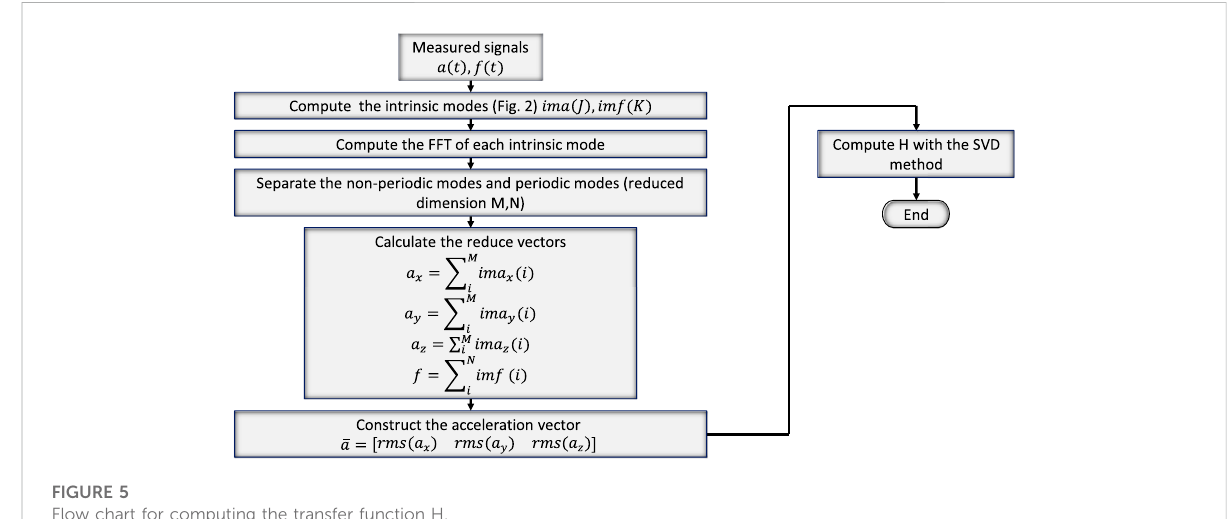
FIGURE 5 Flow chart for computing the transfer function